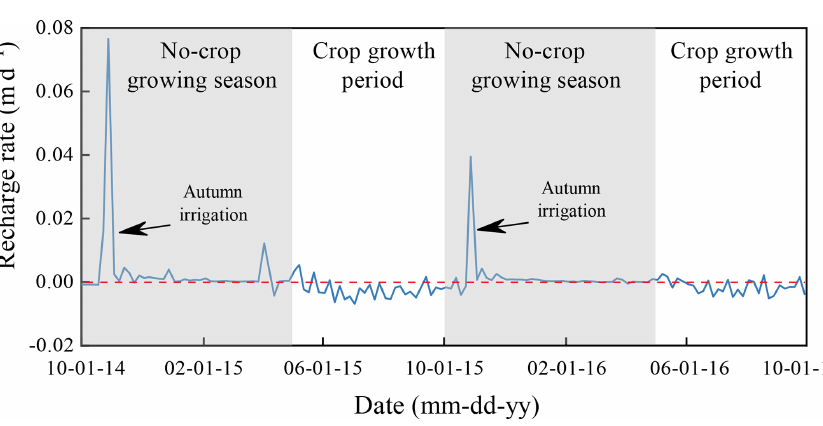
Figure 13. The recharge rate in the farm land calculated by the coupled